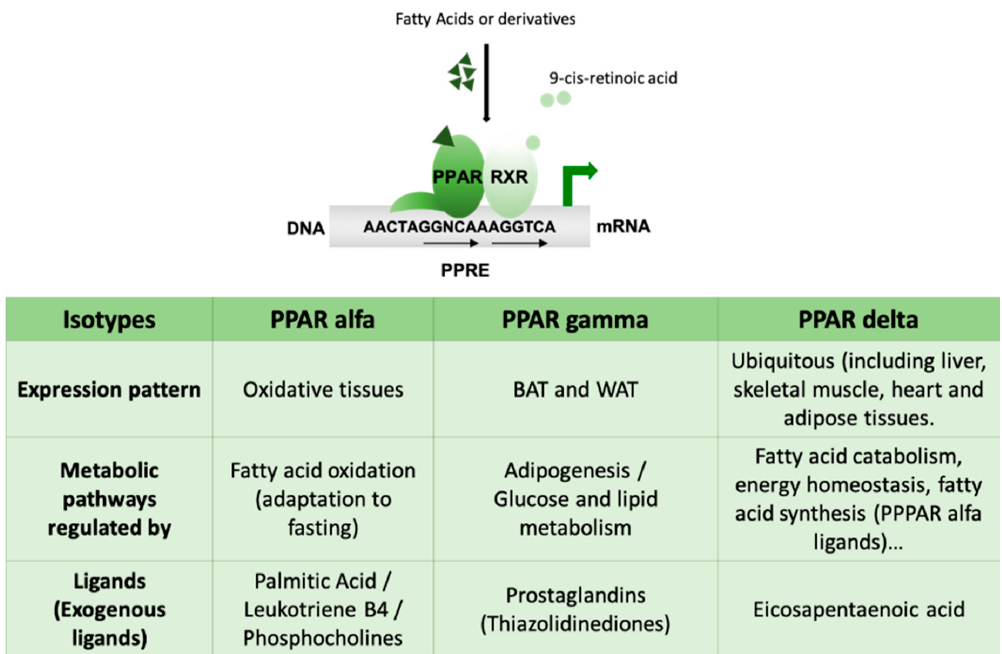
Figure 3. PPARs belong to the ligand-activated nuclear receptor (NR) family. They are transcription factors that exert their effects as heterodimers with the retinoid X receptor (RXR) by binding to a specific sequence of DNA called PPAR-responsive element (PPRE) with a repetitive consensus hexamer (AGGTCA). Three PPAR isotypes are described ( α , β and γ ) with different expression patterns and metabolic functions. PPARs are lipid sensors and can be activated by both dietary fatty acids (FAs) and their derivatives in the body and, consequently, redirect metabolism. In the liver, PPAR α and PPAR δ exhibit opposing activities in the control of diurnal lipid metabolism. PPAR α is upregulated in the fasted state to regulate fat catabolism. By contrast, PPAR δ is most active in the fed state and controls the transcription of lipogenic genes. BAT, brown adipose tissue; WAT, white adipose tissue.